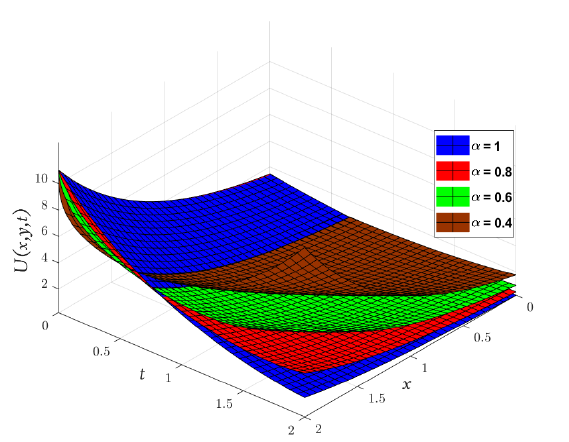
Figure 6. Three-dimensional plots of the approximate and exact solutions of U ( x , y , t ) (Example 3) using the LADM.